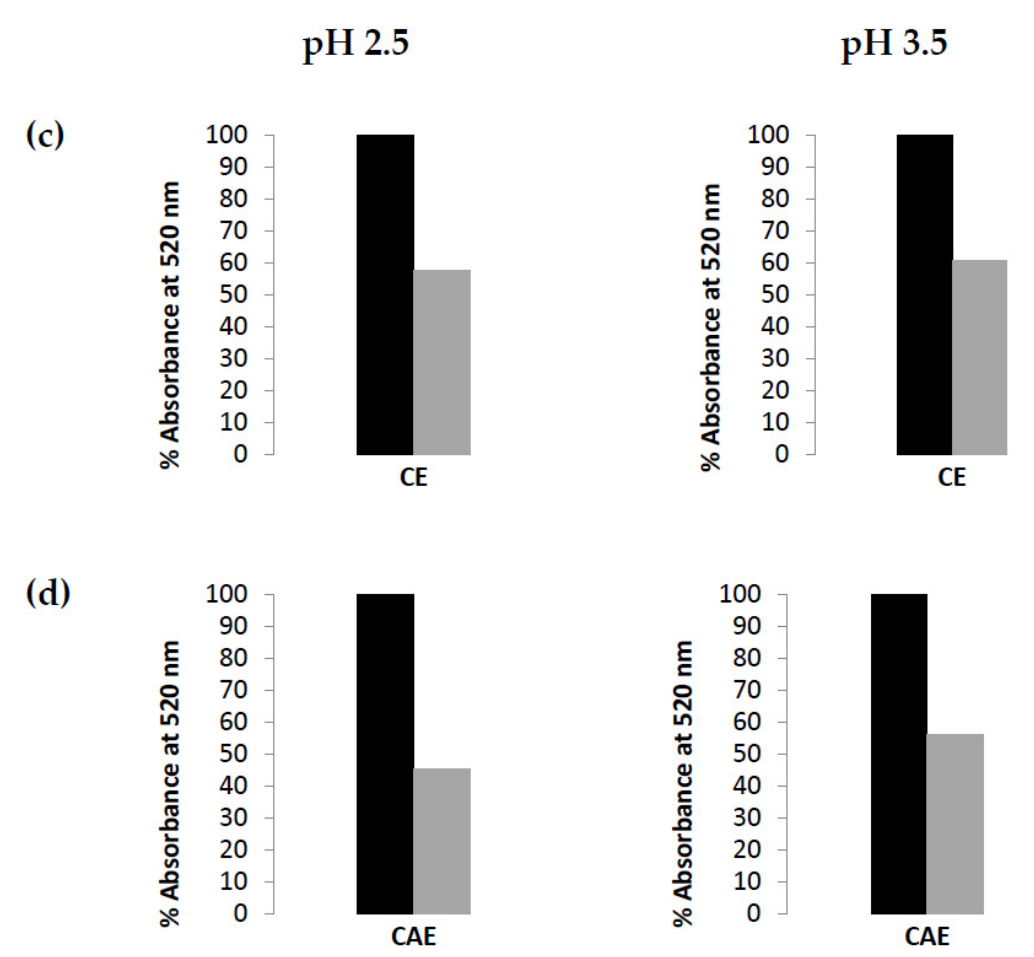
Figure 4. Absorbance values (520 nm) at pH values 2.5 and 3.5 ( a ) first stage aqueous extracts “AE”; ( b ) second stage methanolic extracts “ME”. Black columns indicate absorbances before sulfite bleaching, while gray columns indicate absorbances after sulfite bleaching; CONT. Absorbance values (520 nm) at pH values 2.5 and 3.5 ( c ) cake methanolic extracts “CE”; ( d ) cake acetone extracts “CAE”. Black columns indicate absorbances before sulfite bleaching, while gray columns indicate absorbances after sulfite bleaching.